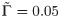
Density and current profiles in the shock phase, for Γ˜=0.05, L = 1 and α˜=0.2.(a,b) β˜=0.15, (c,d) β˜=0.16 and (e,f) β˜=0.17. Numerical simulations are shown as blue (density) and magenta (current) points, whereas analytical predictions for the density profiles are shown as black lines. For the current profiles the analytical expressions for JLD(x) and JHD(x) are shown with green and red dashed lines, respectively.